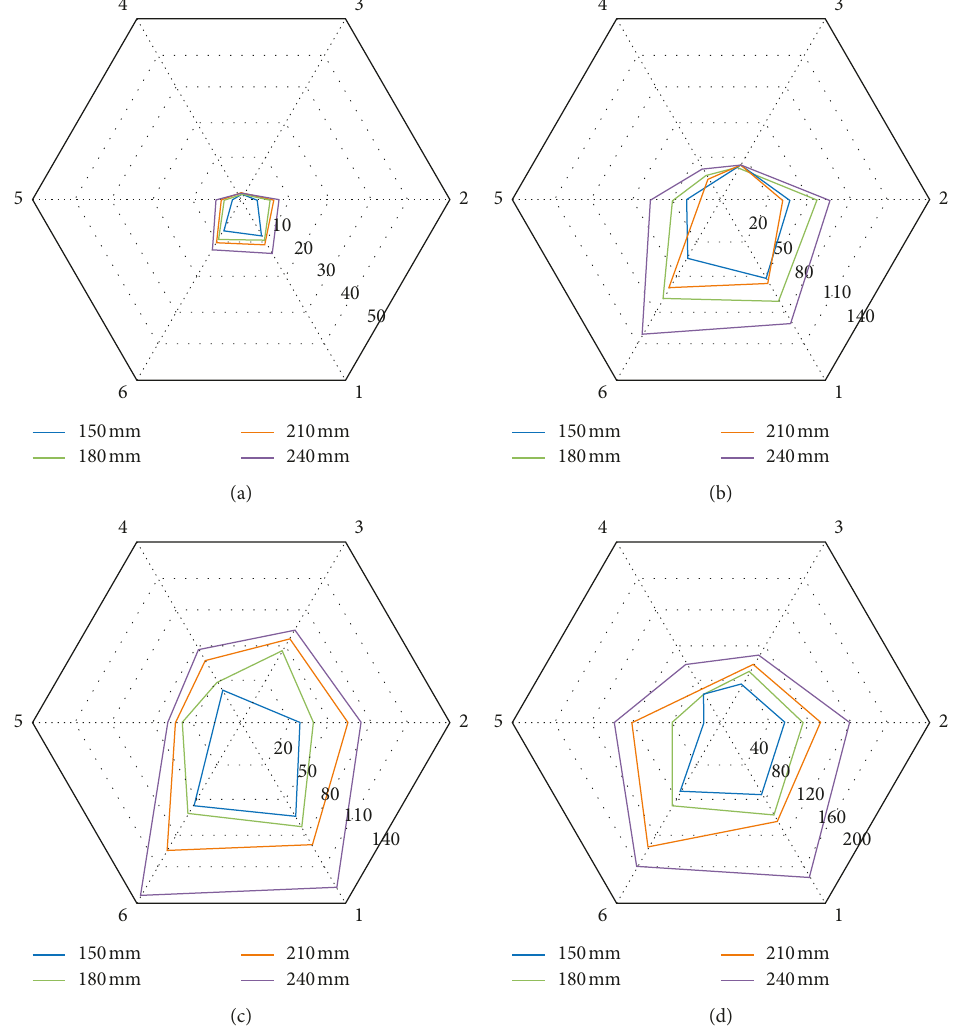
Figure 7: Pressure diagram of the roller group under different pipe diameters: (a) no load, (b) 60% filling rate, (c) 75% filling rate, and (d) full load.